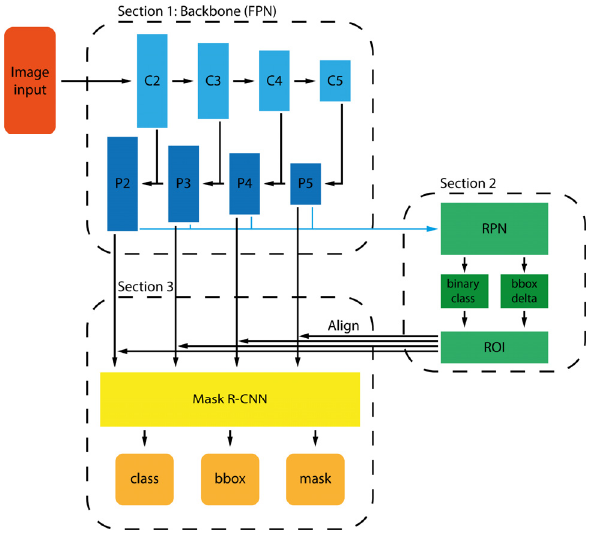
Figure 1. Network